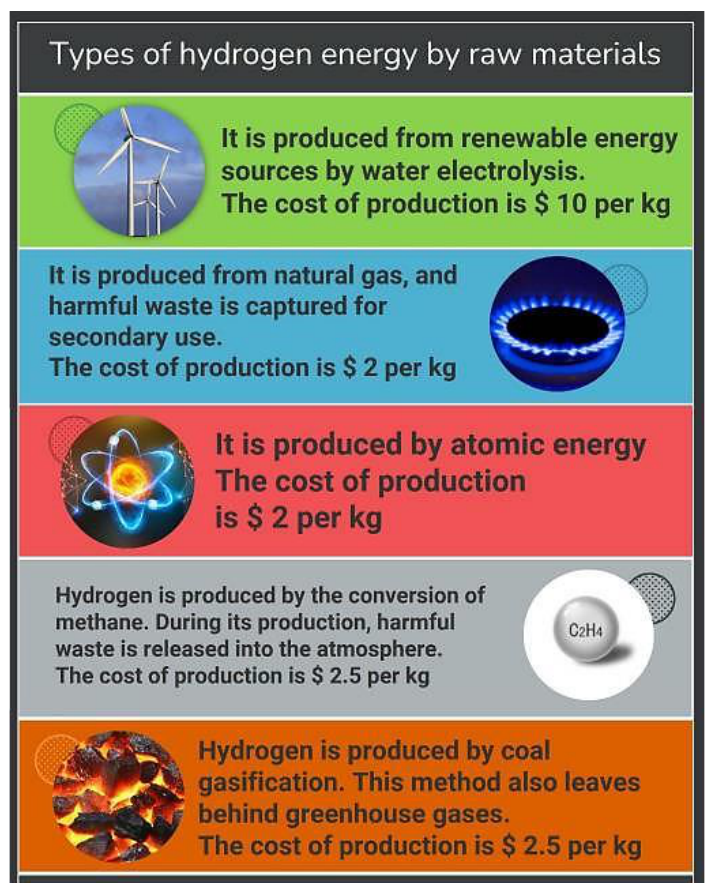
Figure 1. Main types of hydrogen, compiled by sources [28 –